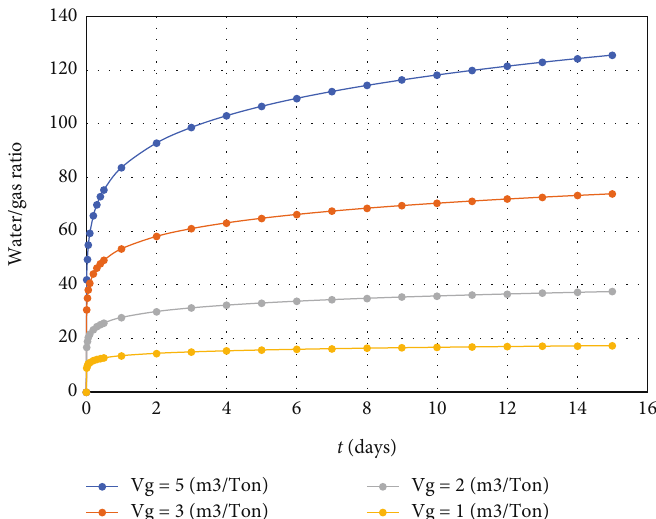
Figure 10: Water-gas ratio under di ff erent free gas contents in